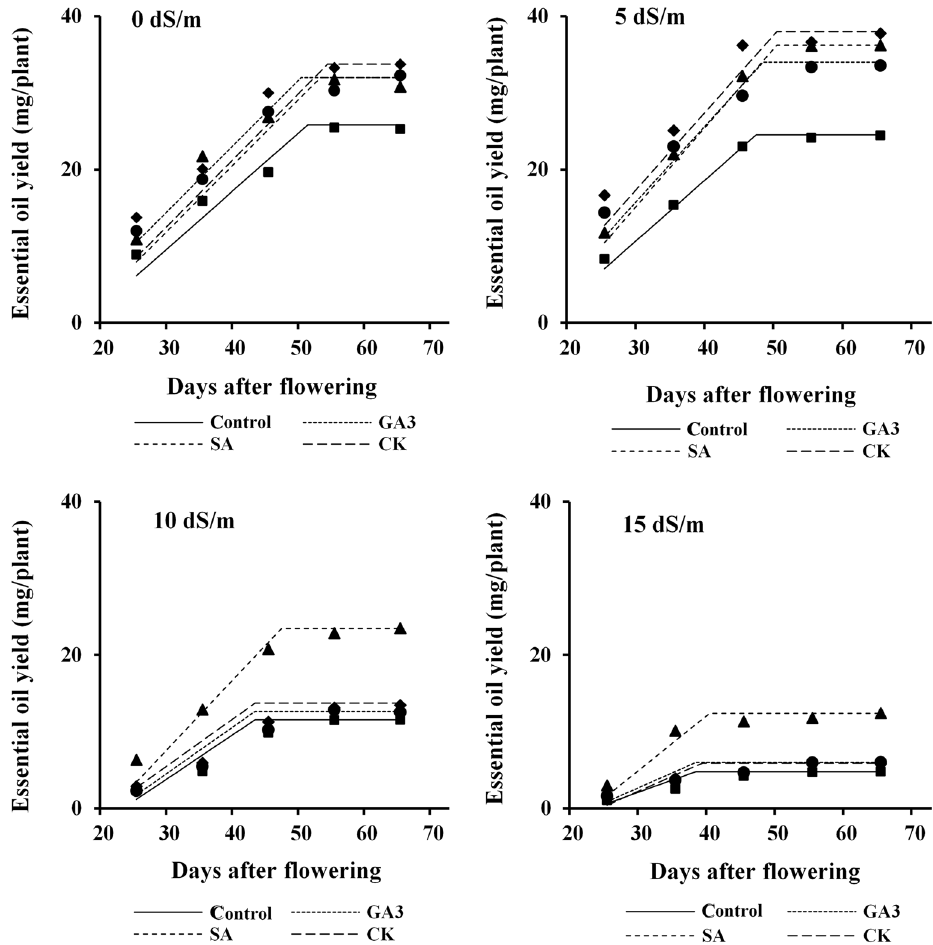
Figure 4. Changes in essential oil yield during dill seed development in response to salinity and hormonal treatments. GA 3 , SA, CK gibberellic acid, salicylic acid and cytokinin,